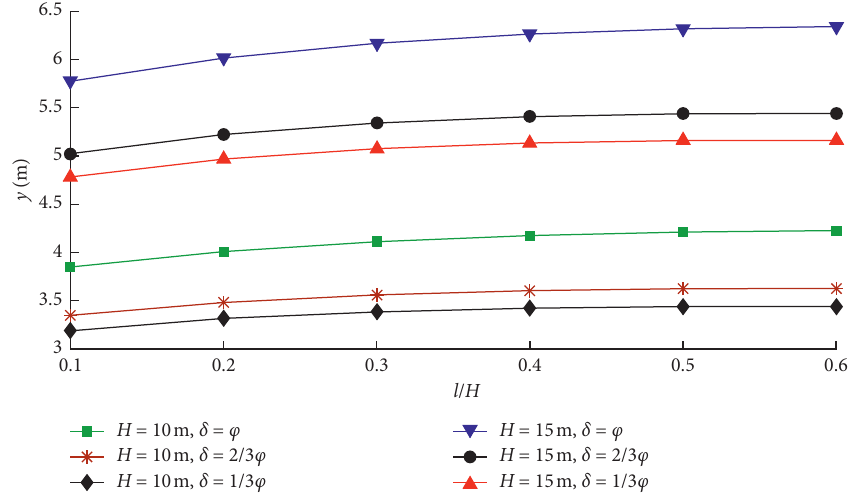
Figure 9: The height of action line of the resultant earth